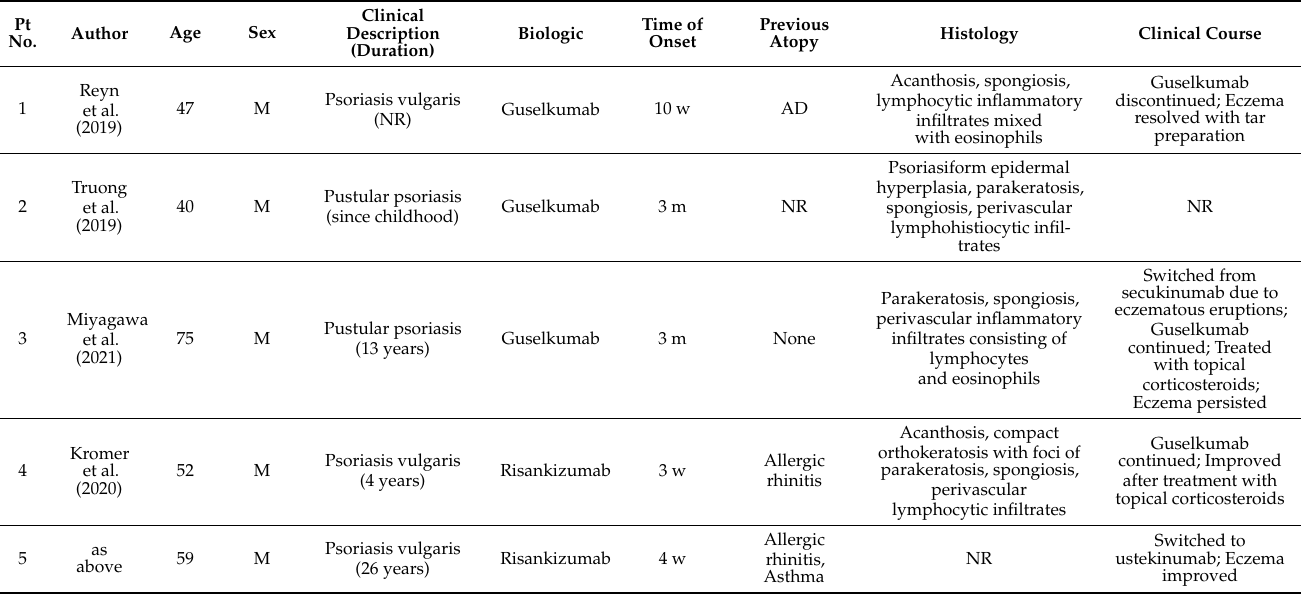
Table 2. Clinical details of cases of eczematous eruptions secondary to IL-23p19 inhibitor